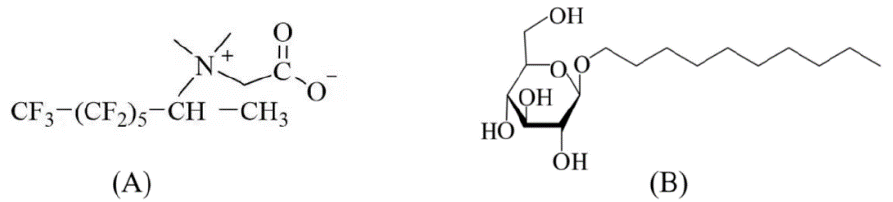
Figure 10. Molecular structures of: ( A ) FS-50 and ( B ) APG0810.